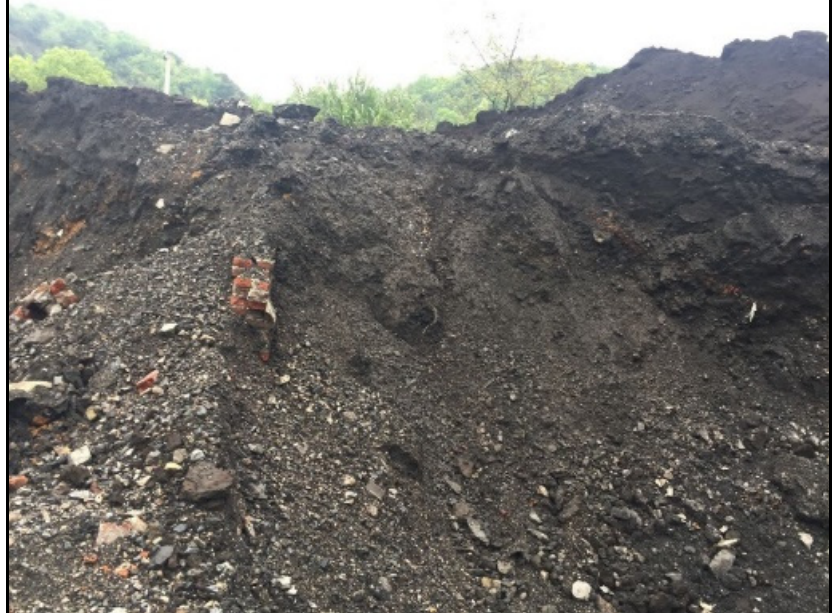
Figure 1. The waste coal gangue of a coal mine.